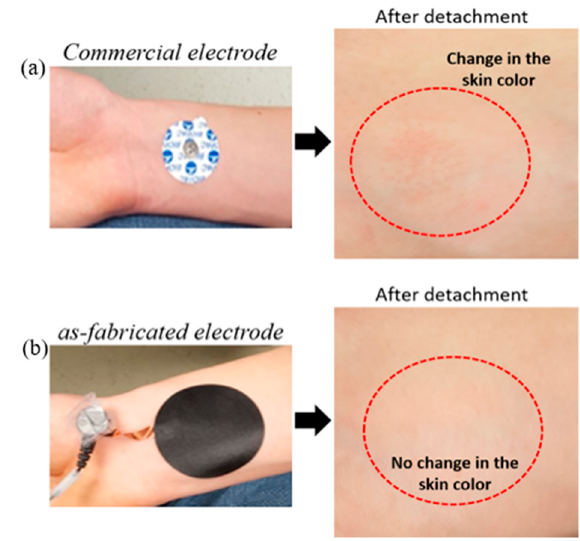
Figure 10. The compatibility test of the electrode in the skin for ( a ) the commercial electrode and ( b ) the as-fabricated electrode.